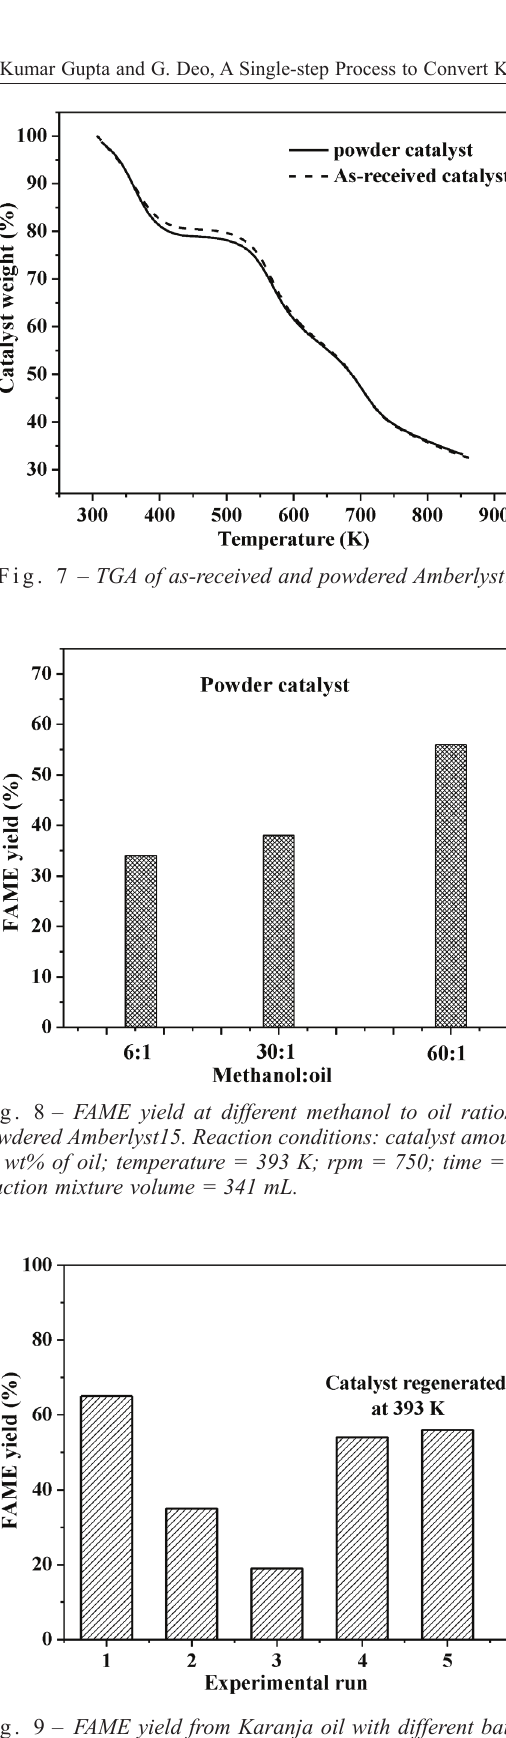
Fig. 9 – FAME yield from Karanja oil with different batches showing deactivation and regeneration of the Amberlyst15 cat- alyst. Reaction conditions: Karanja oil = 250.79 g; methanol to oil ratio = 6:1; catalyst amount = 18 wt% of oil; tempera- ture = 393 K; rpm = 750; time= 8